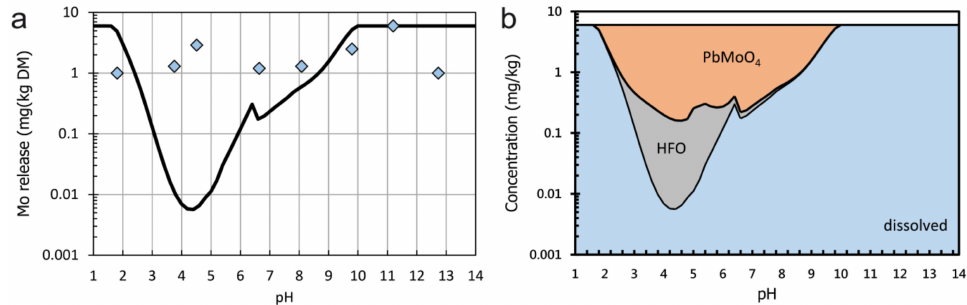
Figure 10. Concentration of Mo in solution as a function of pH for sample E. ( a ) Measured (symbols) and modelled (black line) dissolved concentrations; ( b ) phases which are suggested to control the leachability of by precipitation / dissolution or adsorption / desorption equilibria, resulting in the modelled curve in the left